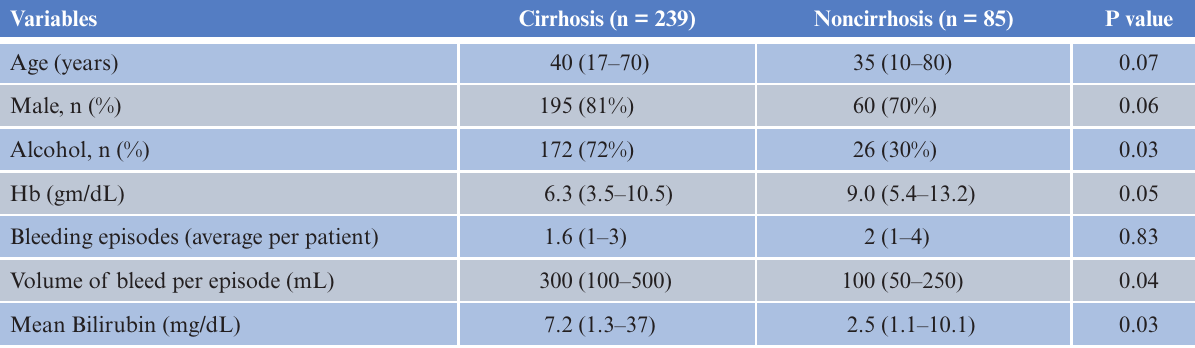
Table 2: Baseline characteristics among cirrhosis and noncirrhosis patients.